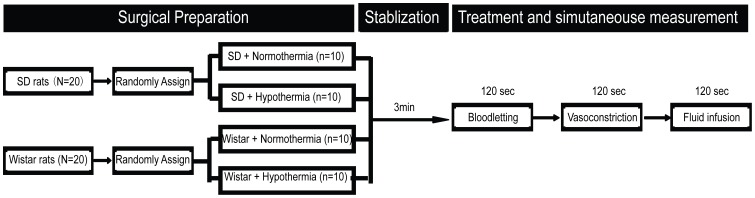
The surgical procedures and simultaneous measurements of BP.